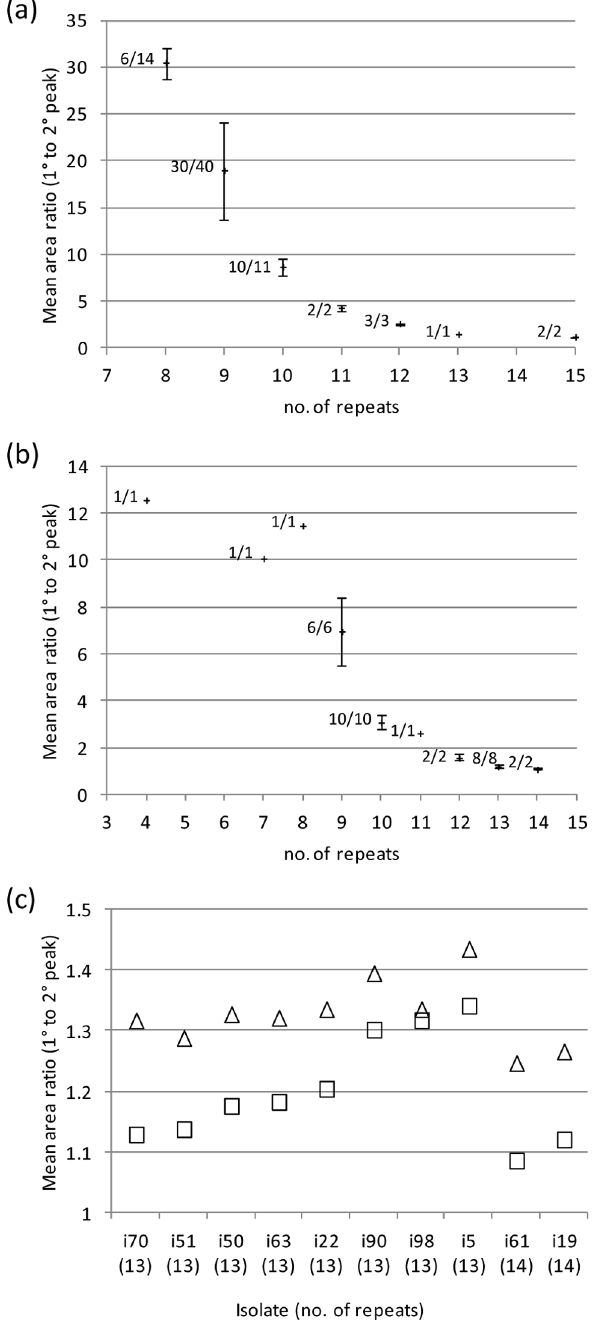
Figure 3. Influence of homopolymeric tract length on the heterogeneity of PCR products. For a proportion of the isolates, amplification across the homopolymeric repeat tracts of hmbR and hpuA generated multiple peaks on fragment analysis. The relative amounts of the respective primary (1˚) and secondary (2˚) products were estimated by calculating the ratio of the corresponding peak areas using Peak Scanner software (Life Technologies Ltd). Charts (a) and (b) illustrate a decrease in mean peak area ratio with increasing absolute homopolymeric tract length (corresponding to the 1˚ peak) for hmbR and hpuA , respectively. The proportions of isolates exhibiting hetero- geneous fragments are indicated beside markers. Hairs indicate standard deviations. All PCRs utilised 25 cycle repeats. Chart (c) compares the mean peak area ratios obtained using 25 (squares) or 20 (triangles) PCR cycle repeats for hpuA + isolates possessing 13 to 14